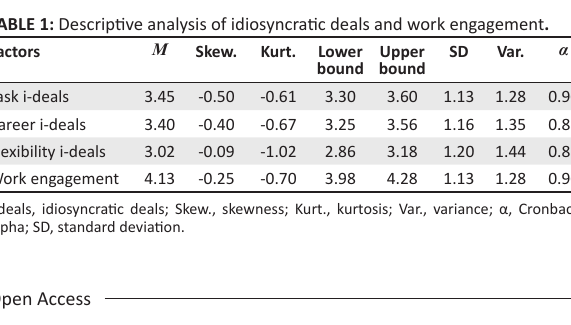
Upper SD Var. bound bound